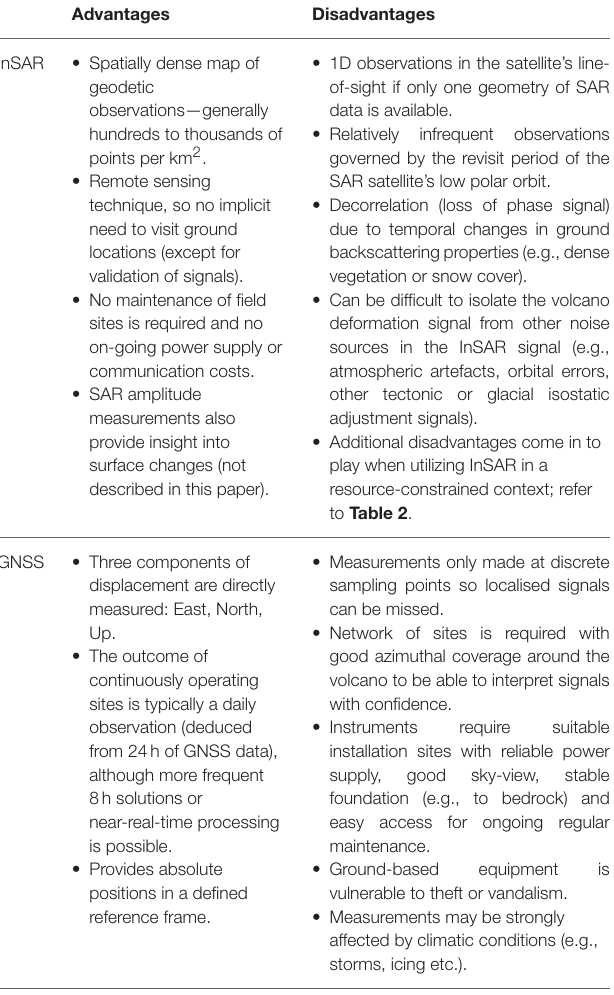
TABLE 1 | Advantages and disadvantages of InSAR and GNSS for monitoring volcano deformation. Advantages